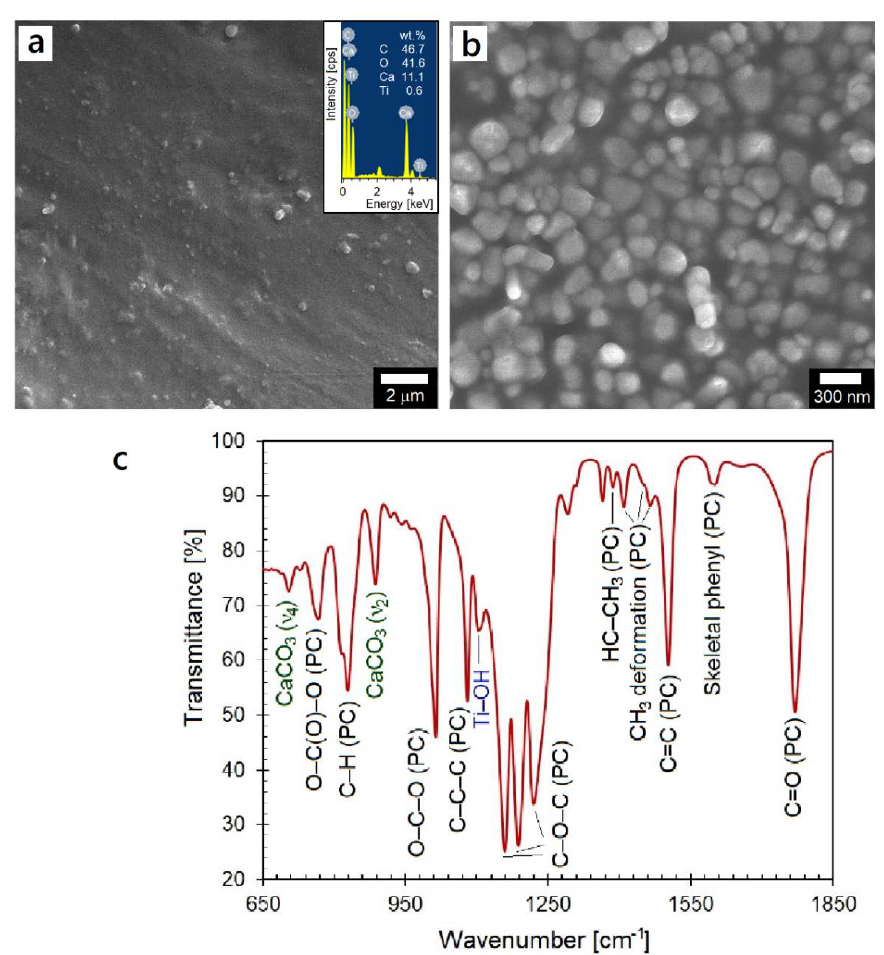
Figure 2. ( a , b ) SEM micrographs of the as-received PC granules with EDS data (inset) and polymer residue upon thermal decomposition; ( c ) FTIR spectrum indicating bonding characteristics of the PC matrix and the nanoparticles.